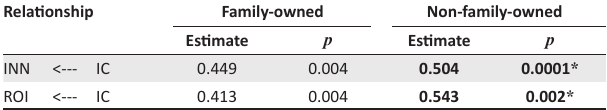
FIG URE 4: Non-family-owned small and medium-sized enterprises. TABLE 6: Group difference analysis.